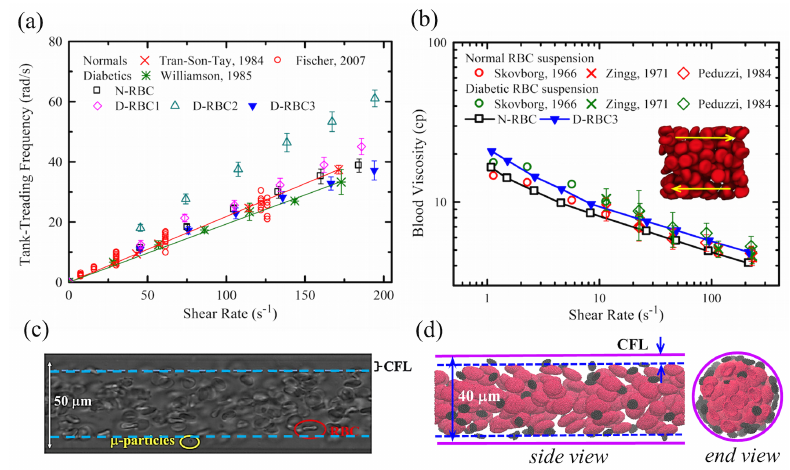
Figure 10. ( a ) Normal and T2DM RBC tank-treading frequency as a function of the shear rate. Simulation results [152] compared with experimental data by Fischer (red circle) [156], by Tran-Son-Tay et al. (red cross) [158], and Williamson et al. (green star) [155]. Linear fits for the experimental data of normal RBCs (red line) and diabetic RBCs (green line). Reproduced from reference [152] with permission. ( b ) Blood viscosity of normal and T2DM RBC suspension as a function of shear rate at a hematocrit of 45%. Simulation results (squares and triangles) [152] compared with experimental data (circles [144], crosses [161], and diamonds [162]). The red and green symbols are for the normal and diabetic RBC suspensions, respectively. Reproduced from reference [152] with permission. ( c ) Typical particle/platelet margination observed in blood flow from an in vitro study [163]. Reproduced from reference[163] with permission. ( d ) A DPD simulation of RBCs and platelets flowing in a circular channel showing an apparent cell-free layer